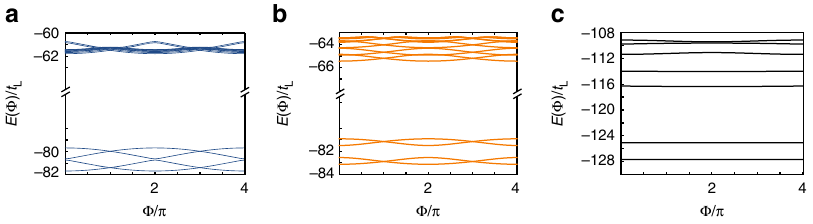
Figure 6 | Energy spectrum in the presence of a nearest-neighbour interaction. Parameters D ¼ 1.01 t ¼ 10 t L , t R ¼ t L and m ¼ m 0 ¼ 0 and interaction strength (c.f. equation 6) ( a ) U ¼ 0.1 t L , ( b ) U ¼ t L and ( c ) U ¼ 10 t L . Note in a and b , the y axis has been cut for